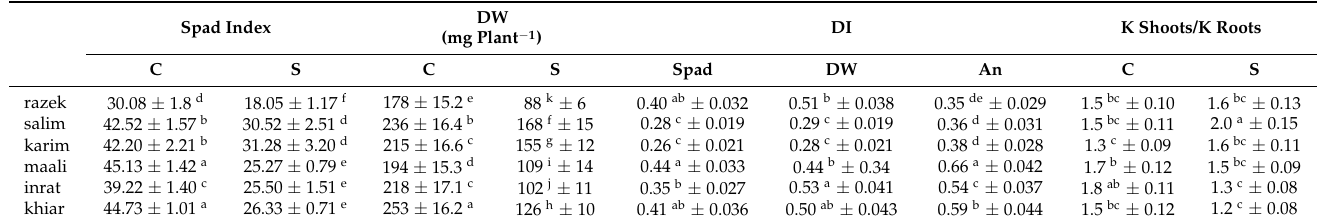
Table 1. Spad index, dry biomass production (DW), drought index calculated based on Spad index (DI-Spad), biomass production (DI-DW), and net photosynthesis (DI-An), and ratio of k shoots to K roots in six Tunisian genotypes of durum wheat ( Triticum durum Desf.) subjected to drought stress. According to Fisher’s least significant difference, within columns, means with the same letter are not significantly different at α = 0.05. Standard errors of means of 30 replicates (10 replicates for K analysis). C: control, S: